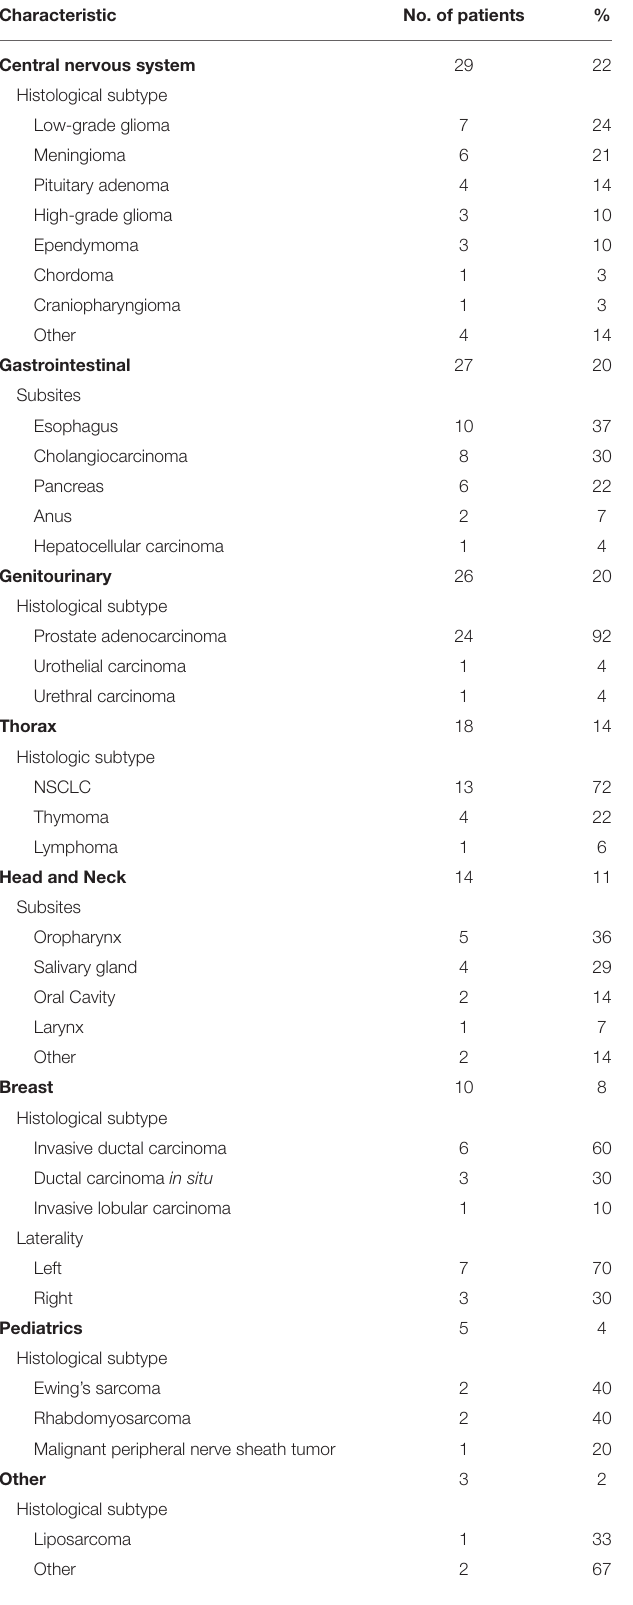
TABLE 3 | Disease site breakdown.